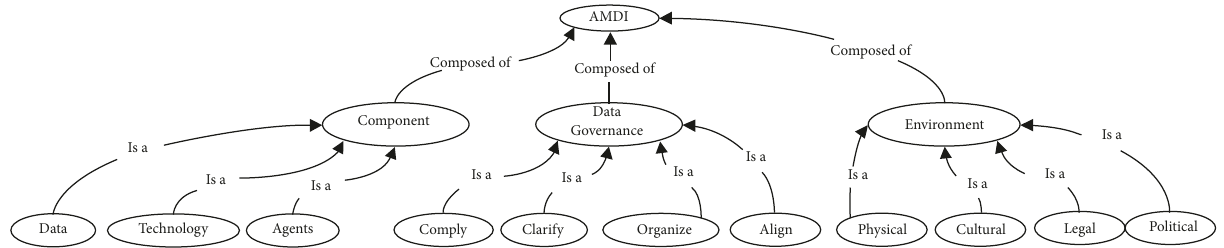
Figure 2: The main elements of the asset management data infrastructure data model.